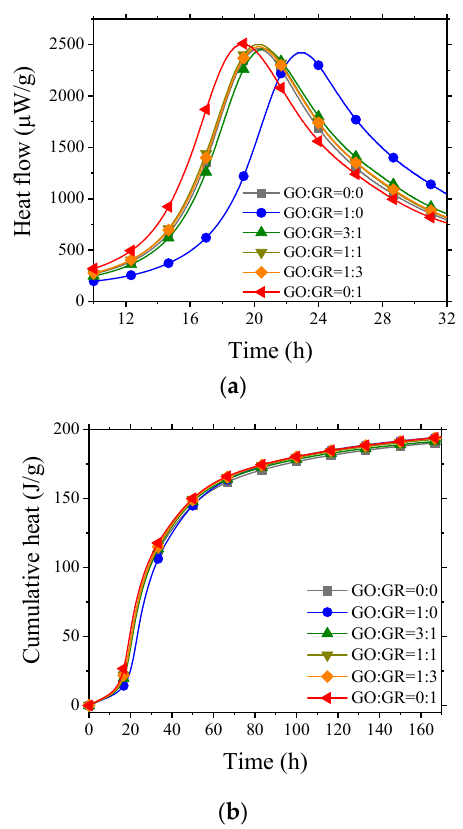
Figure 6. Calorimetry curves of cement with GO/GR hybrid. ( a ) Heat flow; ( b ) Cumulative heat.